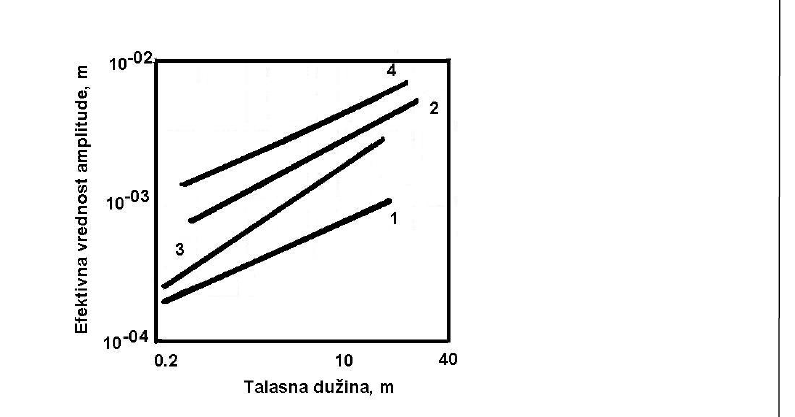
Figure 3 – Limit values of road roughness (1– for modern roads, 2 – for a road with a bad concrete cover, 3 – for a repaired asphalt road and 4 – for a city street in good